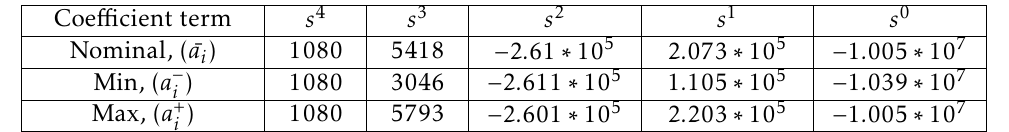
Table 2. Coefficients associated with numerator polynomials.